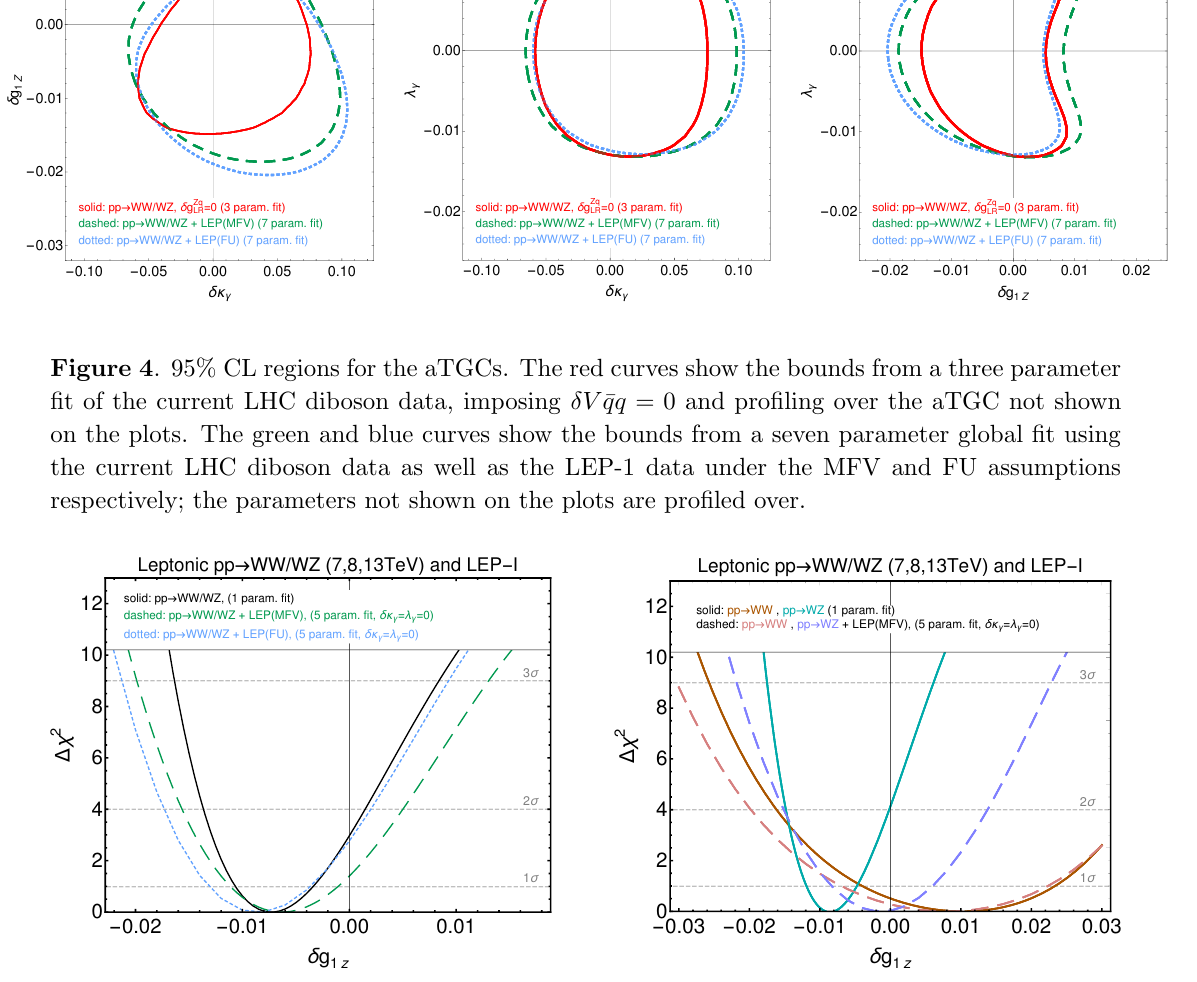
Figure 5 . Constraints on (cid:14)g 1 z assuming (cid:14)(cid:20) (cid:13) and (cid:21) (cid:13) to be loop suppressed, i.e. negligible. In solid, exclusive (cid:12)ts where only (cid:14)g 1 z is taken into account. In dashed and dotted, (cid:12)ts pro(cid:12)ling over the fermion-electroweak boson vertices under the two di(cid:11)erent MFV and FU assumptions respectively. Left: (cid:1) (cid:31) 2 combining all the channels shown in table 1. Right: showing the (cid:1) (cid:31) 2 for the WW and WZ channels